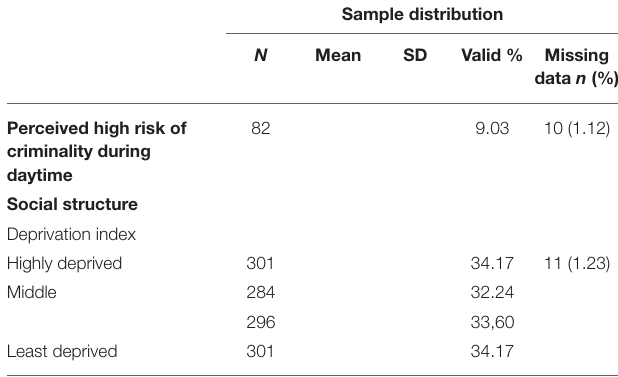
TABLE 1 | Individual and small-area characteristics (baseline survey 2013 to 2016 and perinatal data, N =